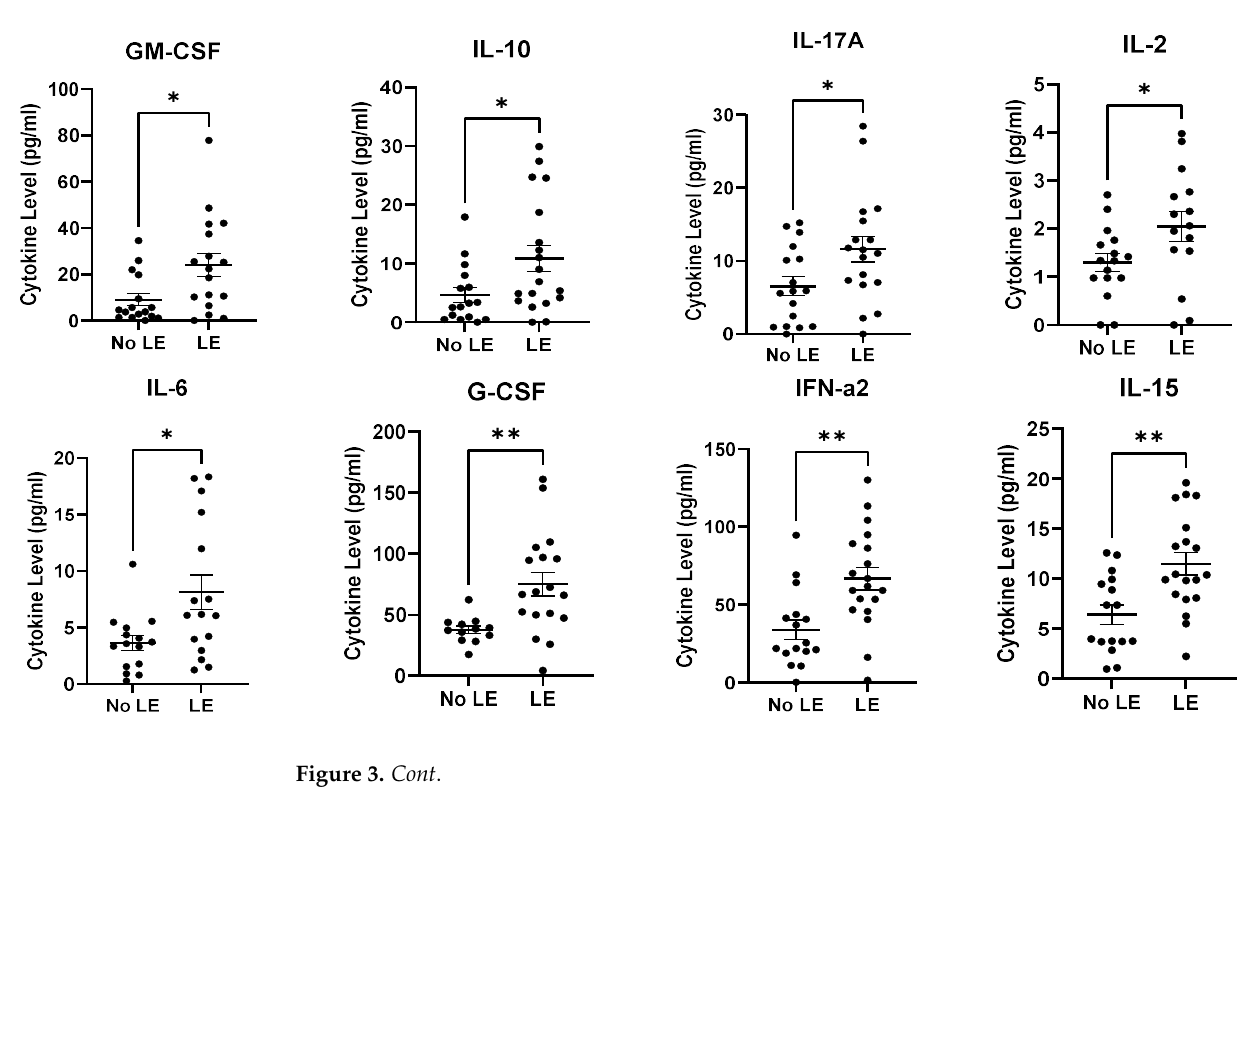
Figure 3. Pre-ALND plasma cytokine/chemokine levels were elevated in subjects displaying clinical BCRL/LE at 12-months post-RT. Of the 14 cytokines analyzed, only IP10 and TNF-α were not sig- nificantly elevated. * p ≤ 0.05, ** p ≤ 0.01, *** p ≤ 0.001, ns = p > 0.05. 3.2. Several Plasma Cytokine/Chemokine Levels Were Elevated at 12 Months after RT in Those with Clinical BCRL Plasma IL-15, IL-3, and MIP-1β levels were found to be significantly higher at 12- months post-RT in comparison to those who did not display BCRL at 12-months post-RT (Figure 4). Other plasma cytokine/chemokine levels did not reach significance, but several trended upwards (Figure S1).